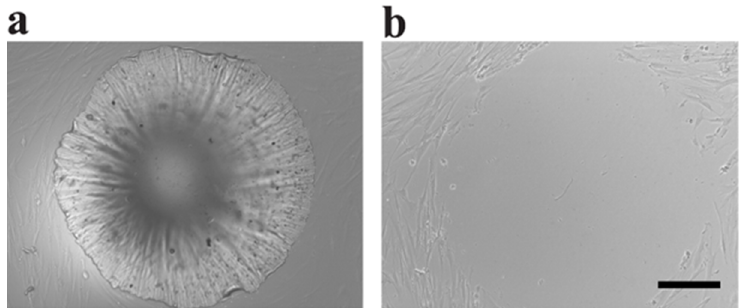
Figure 3. A TPE post and cells. ( a ) Fibroblasts cells are cultured surrounding the pre-positioned post structure in the 96-well plate. ( b ) Following post structure removal, the cell migration assay is performed by capturing cell images. The scale bar represents 200 µm.